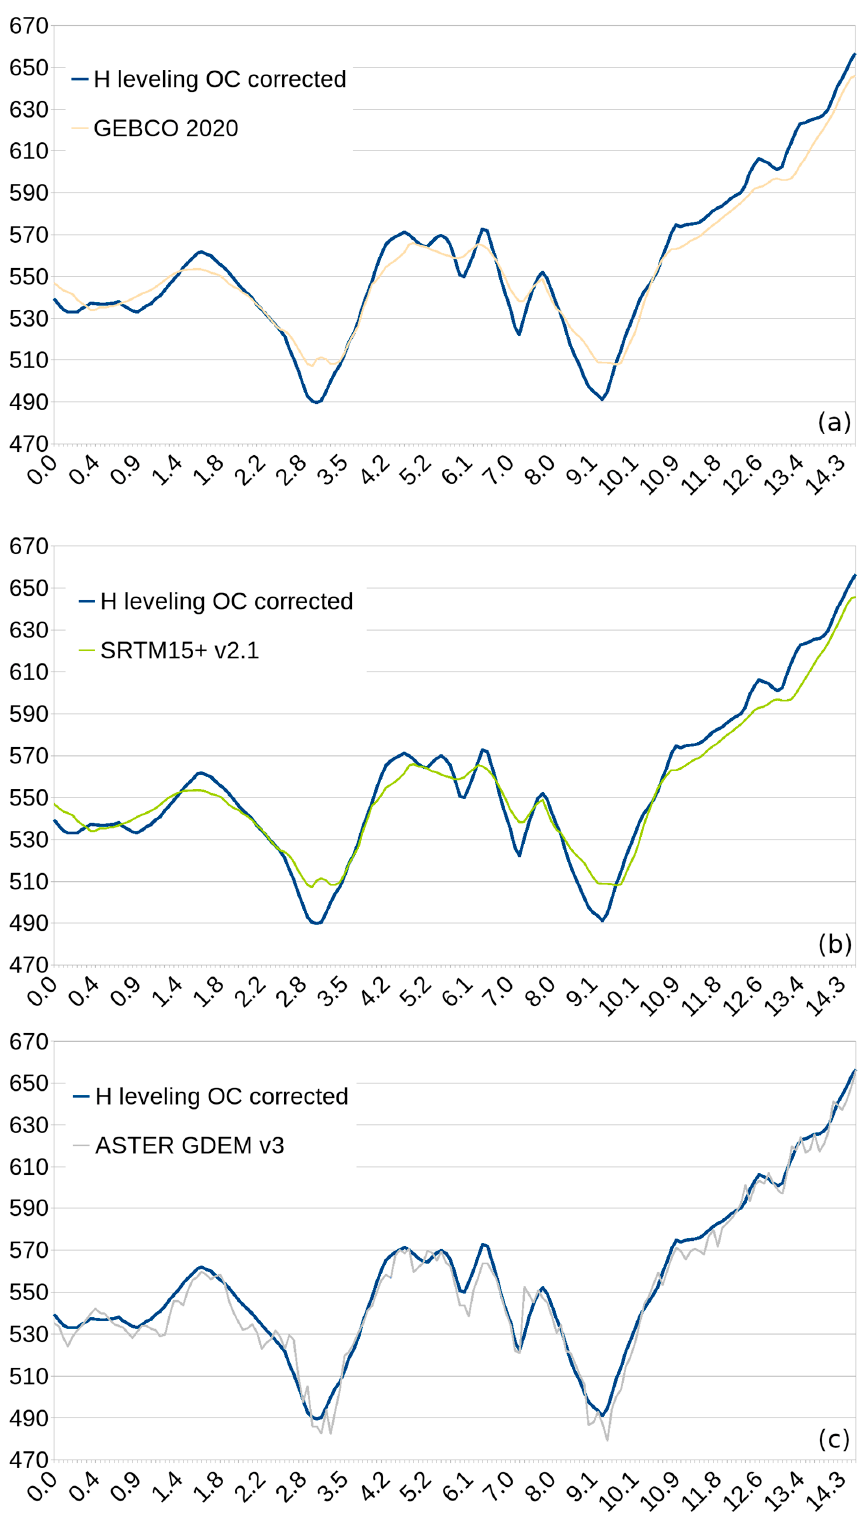
Figure 6. Height values along the traverse in Northern Greece from ( a ) GEBCO 2020 (light orange line) and leveling, ( b ) SRTM15+ (light green line) and leveling, and ( c ) ASTER GDEM v3 (gray line) and leveling. ( x ‐ axis: distance in km/ y ‐ axis: height in m).